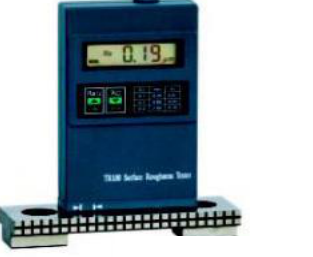
Fig.1: RT(100) stylus profilometer